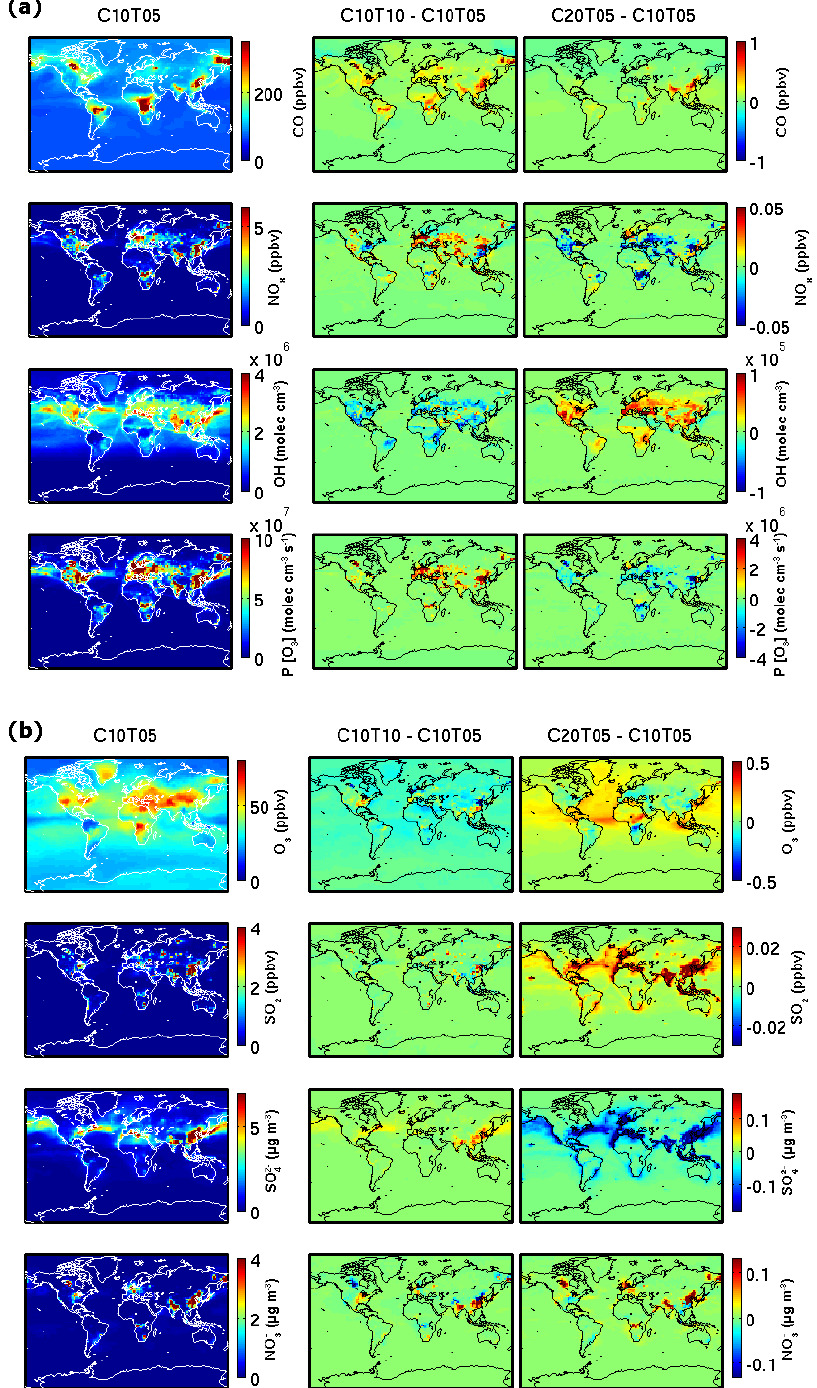
Figure 2. (a) Sensitivity of simulated species to the duration of chemical and transport operators. The left column contains monthly mean ground-level concentrations simulated with the shortest operator duration considered (C10T05) at 2 ◦ × 2.5 ◦ horizontal resolution. Other columns contain the absolute differences from doubling the transport operator duration to C10T10 (middle), and doubling the chemical operator duration to C20T05 (right). Each row from top to bottom represents carbon monoxide (CO), nitrogen oxides (NO x ), hydroxyl radical (OH), and the production of ozone ( P [O 3 ]). Simulations are represented as CccT tt with chemical operator duration, C = cc min, and transport operator duration, T = tt min. (b) As described in panel (a) , but each row from top to bottom represents ozone (O 3 ), sulfur dioxide (SO 2 ), sulfate (SO 2 − ), and nitrate (NO − 4 3